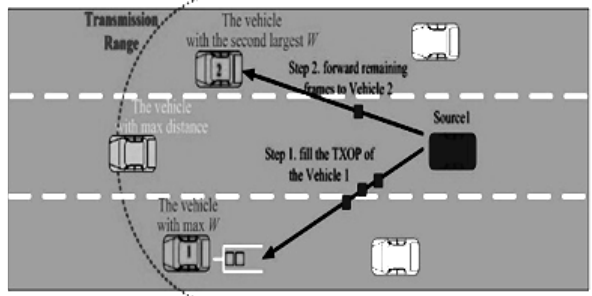
Fig. 2. Frame dispatching when the capacity of the vehicle with the maximum W is not enough where is the number of available frames the vehicle with the maximum W possesses, 𝑚 𝑛 𝑓 expiration time of the vehicle with the maximum W , and is the determined TXOP limit. The remaining frames not forwarded by the node with the largest W value 𝑇 𝑙 would